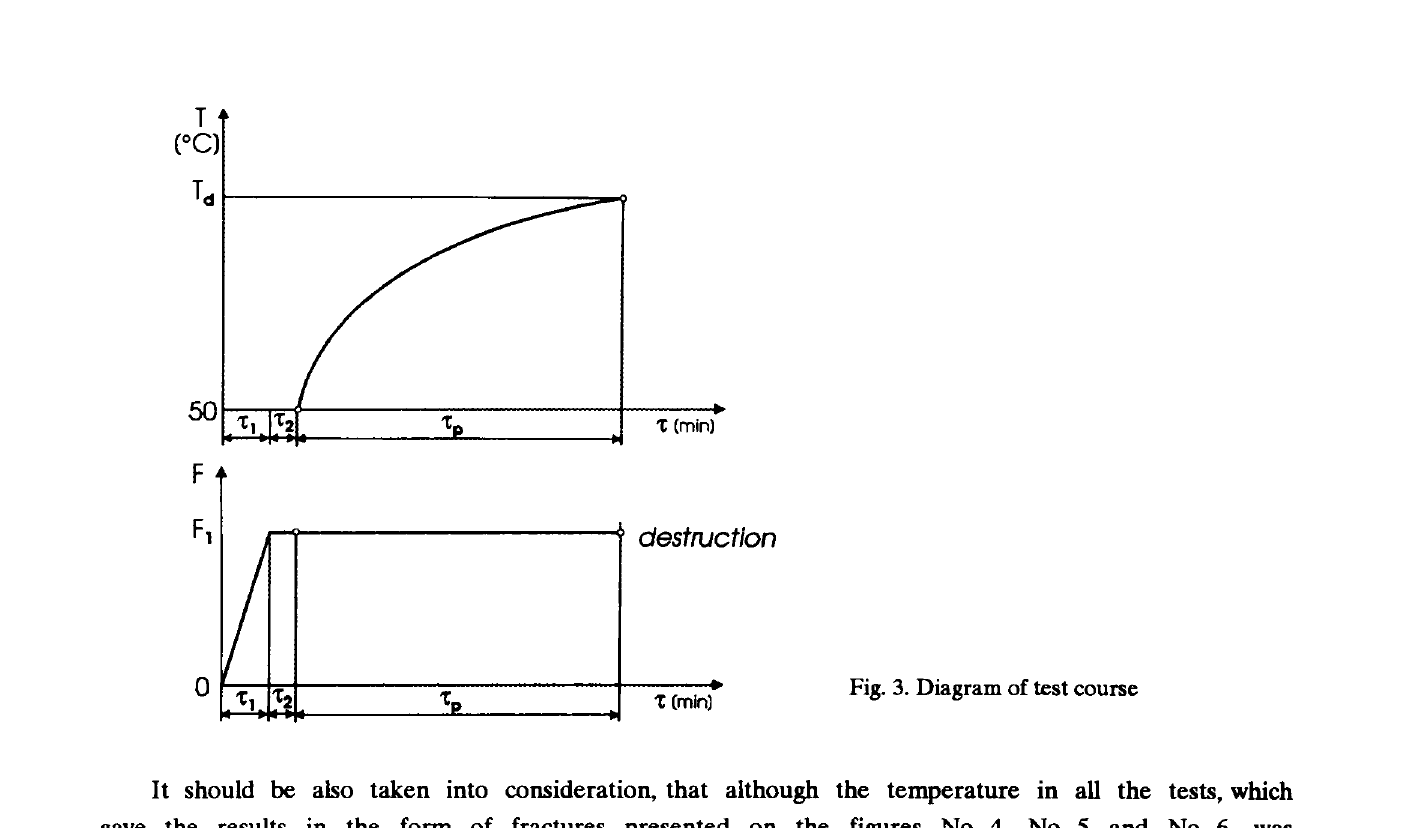
Fig. 3. Diagram of test course